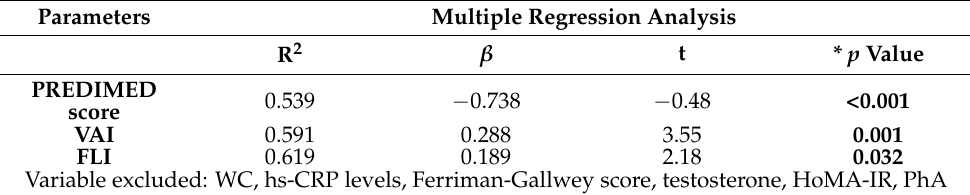
Table 6. Regression linear analysis to estimate the predictive value of WC, PREDIMED score, hs-CRP levels, hormonal parameters, cardio-metabolic indices, and PhA on the presence of the MUO-PCOS phenotype.